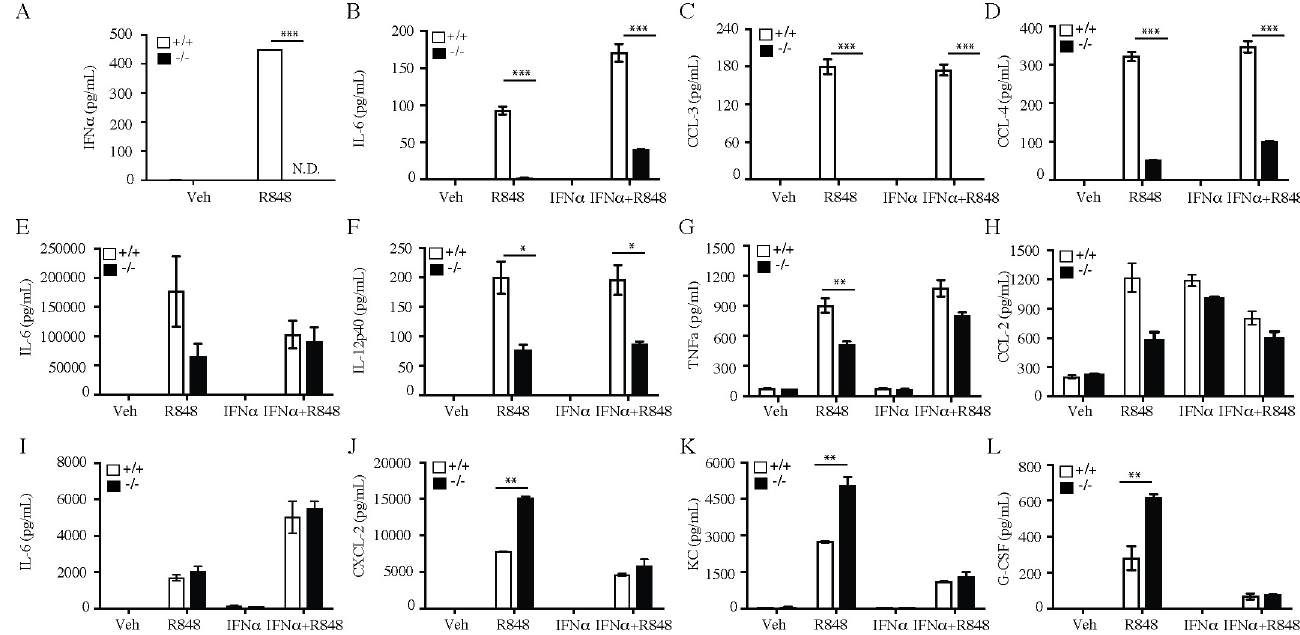
Fig 1. SLC15A4 regulates TLR7 induced inflammatory cytokine secretion in dendritic cells and macrophages. (A) Secretion of IFN α by bone marrow derived pDC in response to R848 stimulation (B-L) Cytokine/chemokine secretion by bone marrow derived pDC (B-D), myeloid DC (E-H), and macrophages (I-L) in response to stimulation with 1 μ g/ml of R848, or 5U/ml IFN α , or stimulation with both agents. Cytokine / chemokine levels in supernatants were assessed by Luminex (Bio-Rad platform) after 24 hours of stimulation and data is expressed as mean ± SD for triplicate samples (n = 3). White bars, wild-type mice (C57BL/6); black bars, slc15a4 -/- mice (on C57BL/6 background). Comparisons were made between wildtype group and knockouts or heterozygous groups � p < 0.05, �� p < 0.005, ��� p < 0.0005.